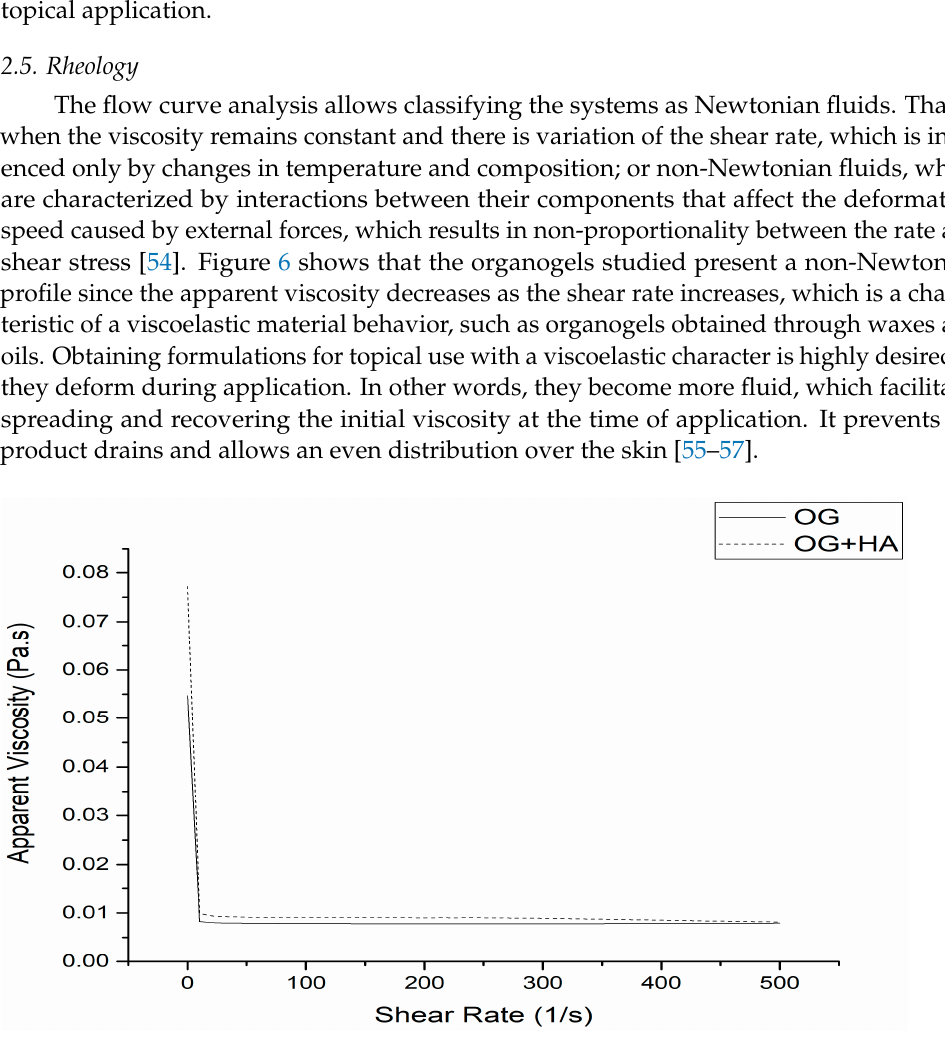
Figure 6. Apparent viscosity of OG and OG + HA.